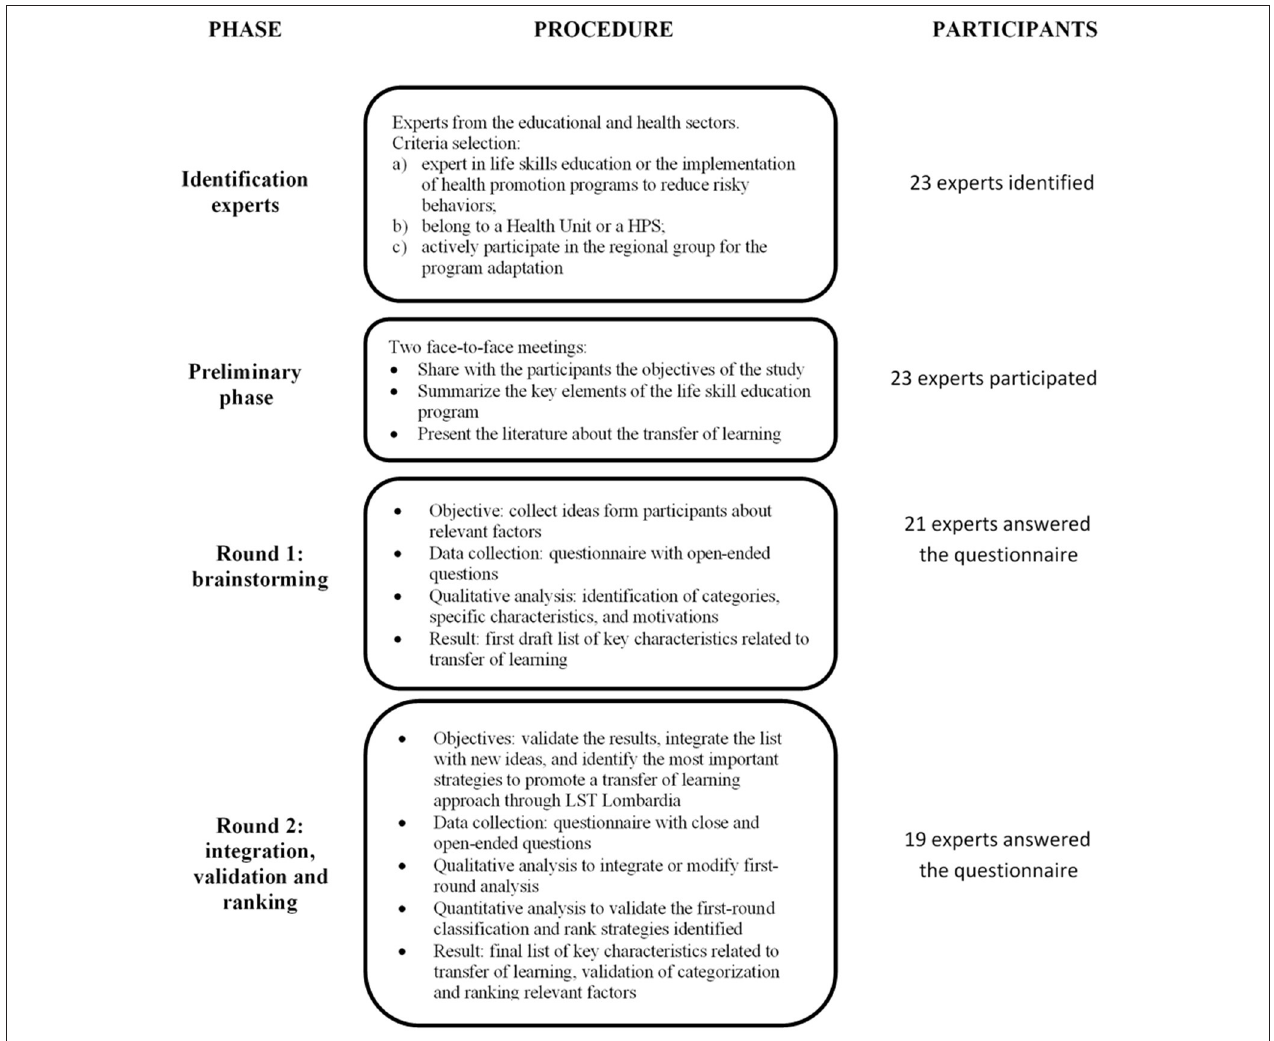
FIGURE 1 | Delphi study